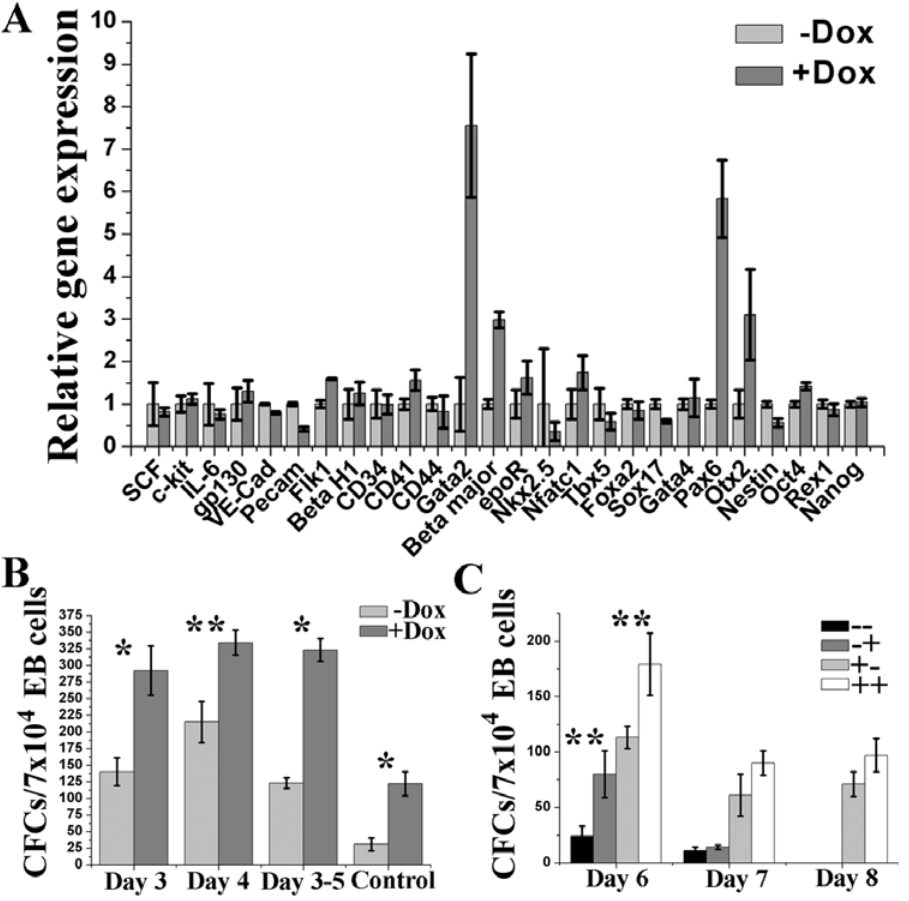
Figure 6. Lhx2 expression in intact EBs transiently induce expansion of definitive hematopoietic progenitor cells in the absence of exogenously added growth factors. A. Gene expression analysis by real-time PCR on day 6 EB generated from the iLhx2 ES cells comparing control EBs ( 2 Dox) to those where Lhx2 expression was turned on at day 4 of differentiation ( + Dox). B. Frequency of definitive CFCs responding to SCF/IL-6/epo in clonal assays of day 6 EBs in the presence ( + Dox) or absence ( 2 Dox) of dox, if dox was added at day 3 or 4 of differentiation, or if dox was present between day 3 and 5 of differentiation. Control is day 6 EBs generated without dox. C. Frequency of definitive CFCs responding to SCF/ IL-6/epo in clonal assays of day 6, 7 and 8 EBs in the presence ( 2 Dox) of absence ( + Dox) of dox if dox was added or not at day 4 of differentiation. Hence, the following combinations were analysed: 22 no dox added to the ES cells differentiation or to clonal assays of EB cells, 2 + dox was added to clonal assays of day 6, 7 and 8 EB cells. + 2 dox was added to day 4 EB and no dox was added to clonal assays of the day 6, 7 and 8 EB cells. ++ dox was added to day 4 EBs and to the clonal assays of the day 6, 7 and 8 EB cells. Asterisks indicate where the difference in CFC between clonal assays performed in the absence or presence of dox is statistically significant, *p , 0,005, **p ,